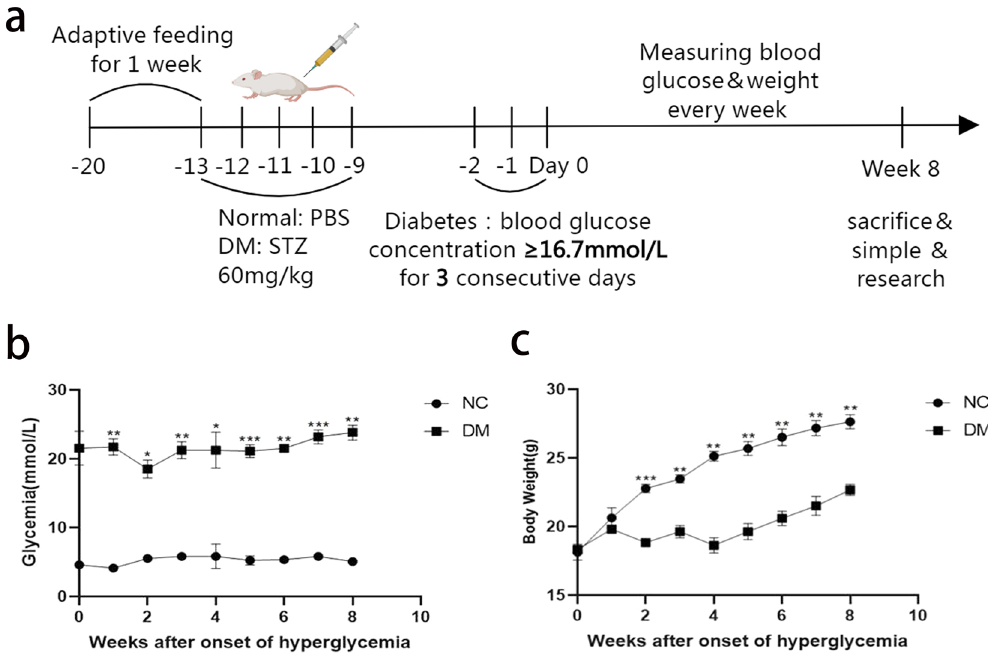
Figure 1. Flow diagram of experiments and conventional indicators of mice. Timetable and flowchart of mice treatment and identification of mice DN model ( a ). Fasting blood glucose was measured every 7 days in normal and DM mice ( b ), the changes in body weight of normal and DM mice were measured every 7 days ( c ). NS showed no significant difference ( P > 0.05), * P < 0.05, ** P < 0.01, *** P < 0.001. NC, normal control, DM, diabetes